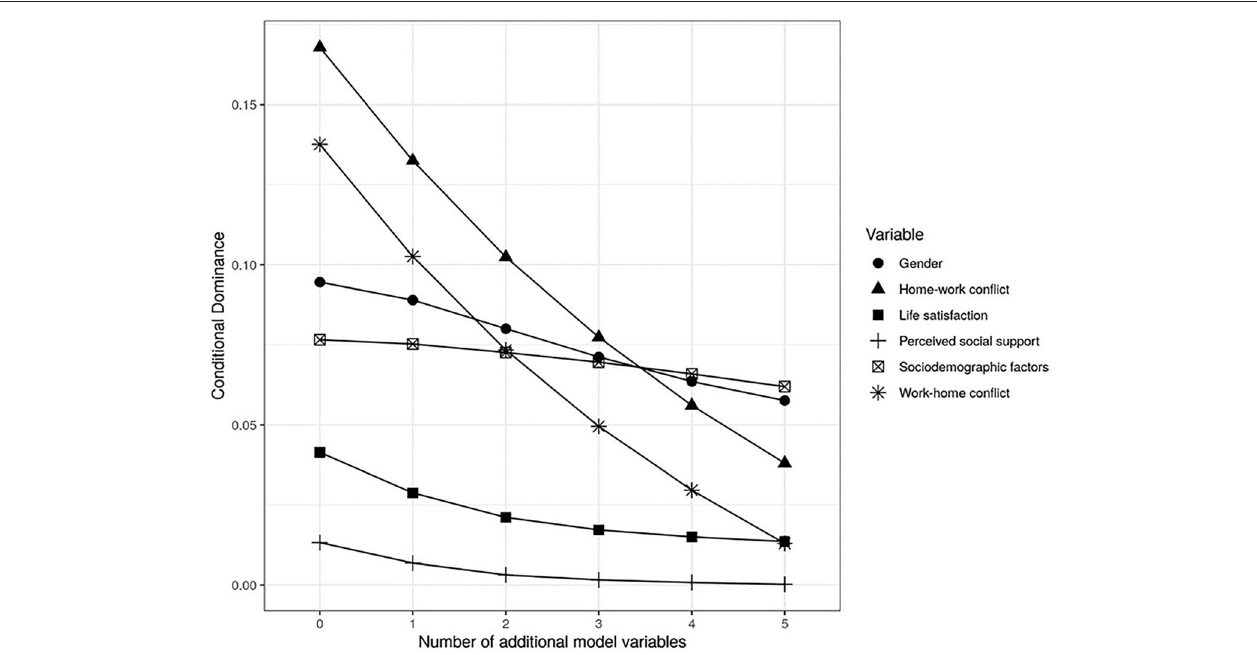
FIGURE 2 | Conditional dominance analysis of parental stress with control variables and psychosocial predictors.